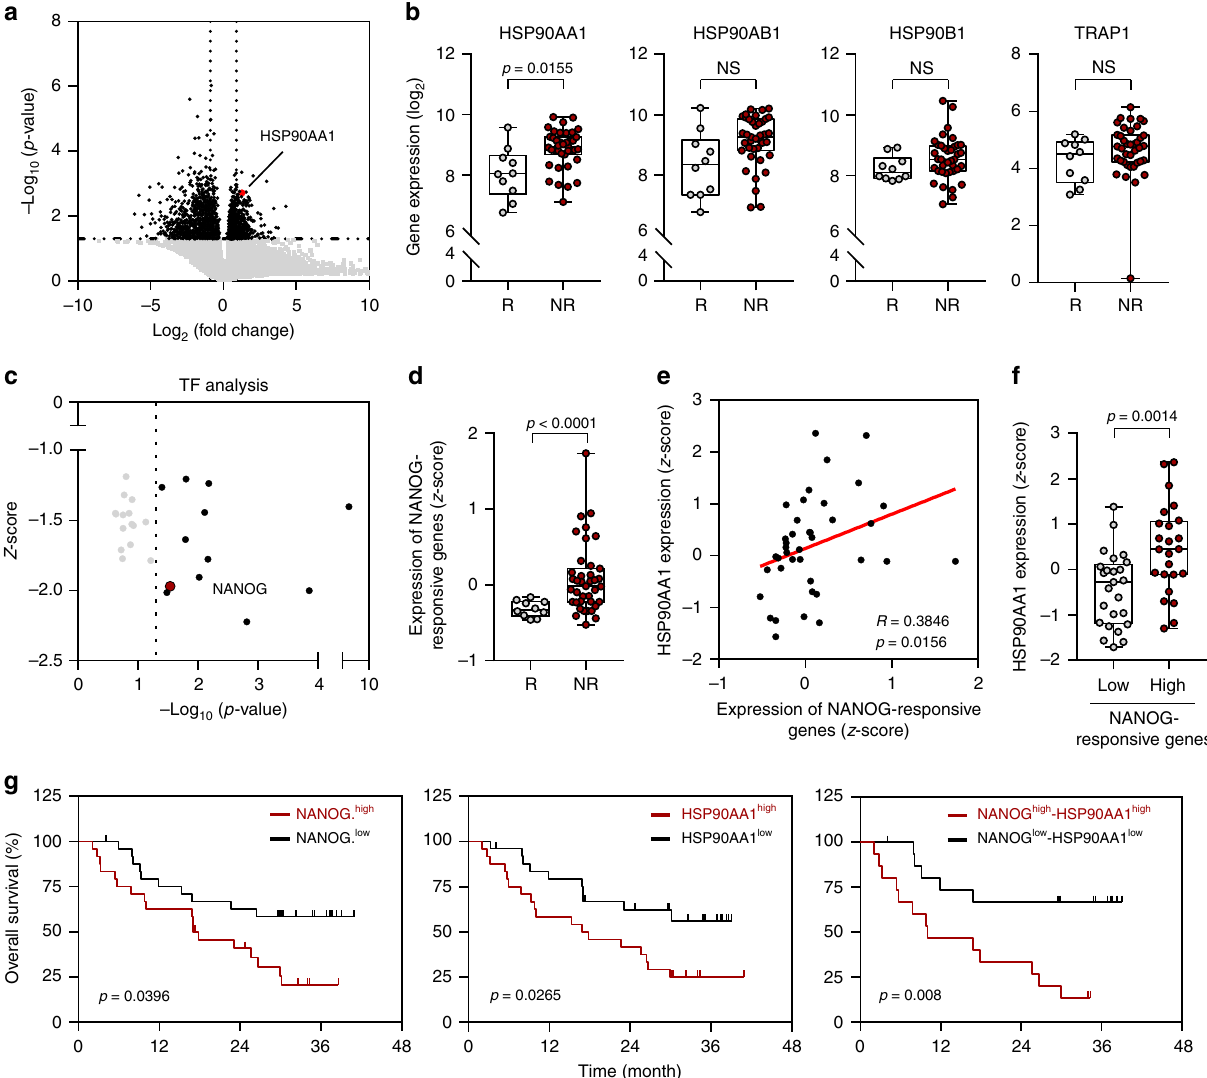
Fig. 7 NANOG – HSP90AA1 axis is associated with poor response to PD-1 blockade therapy. a Volcano plot shows the DEGs between non-responder and responder to PD-1 blockade therapy. Colors of dots indicate signi fi cantly (black) or non ‐ signi fi cantly (gray) altered genes in above or below the horizontal dashed line at p = 0.05. Red dot indicates the HSP90AA1 gene. Vertical dashed lines indicate a fold change cut off (1.5FC). The p -values were determined by two-tailed test. b Comparisons of expressions levels of HSP90AA1, HSP90AB1, HSP90B1, and TRAP1 in responder (R, n = 10) and non-responder (NR, n = 39). c TF analysis of up-regulated DEGs in non-responders relative to responders to anti-PD-1 therapy. Each dot represents one TF which has transcription factor motifs enriched in DEGs. Vertical dashed line indicates p -value cutoffs at the 0.05 level. d Comparisons of expression level of NANOG- responsive genes in the responder (R, n = 10) and non-responder (NR, n = 39). e Correlation between expression level of NANOG-responsive genes and HSP90AA1 in non-responder (Spearman ’ s R = 0.3846, p = 0.0156). f Comparisons of HSP90AA1 expression in non-responders with low levels (Low n = 18) and high levels (High, n = 21) of NANOG-responsive genes. Error bars represent standard deviations from the mean. The p -value by unpaired t -test are indicated. g Kaplan – Meier analysis of overall survival (calculated as months to death or months to last follow-up) and median expression value cutoffs for expression level of NANOG-responsive genes (left, NANOG. high > median; NANOG. low < median, p = 0.0396) and HSP90AA1 (HSP90AA1 high > median; HSP90AA1 low < median, p = 0.0265, middle) and combined each ( p = 0.008, right). The p -values were determined by Gehan – Breslow – Wilcoxon test. In the box plots, the top and bottom edges of boxes indicate the fi rst and third quartiles, respectively; the center lines indicate the medians; and the ends of whiskers indicate the maximum and minimum values, respectively. Source data are provided as a Source Data fi